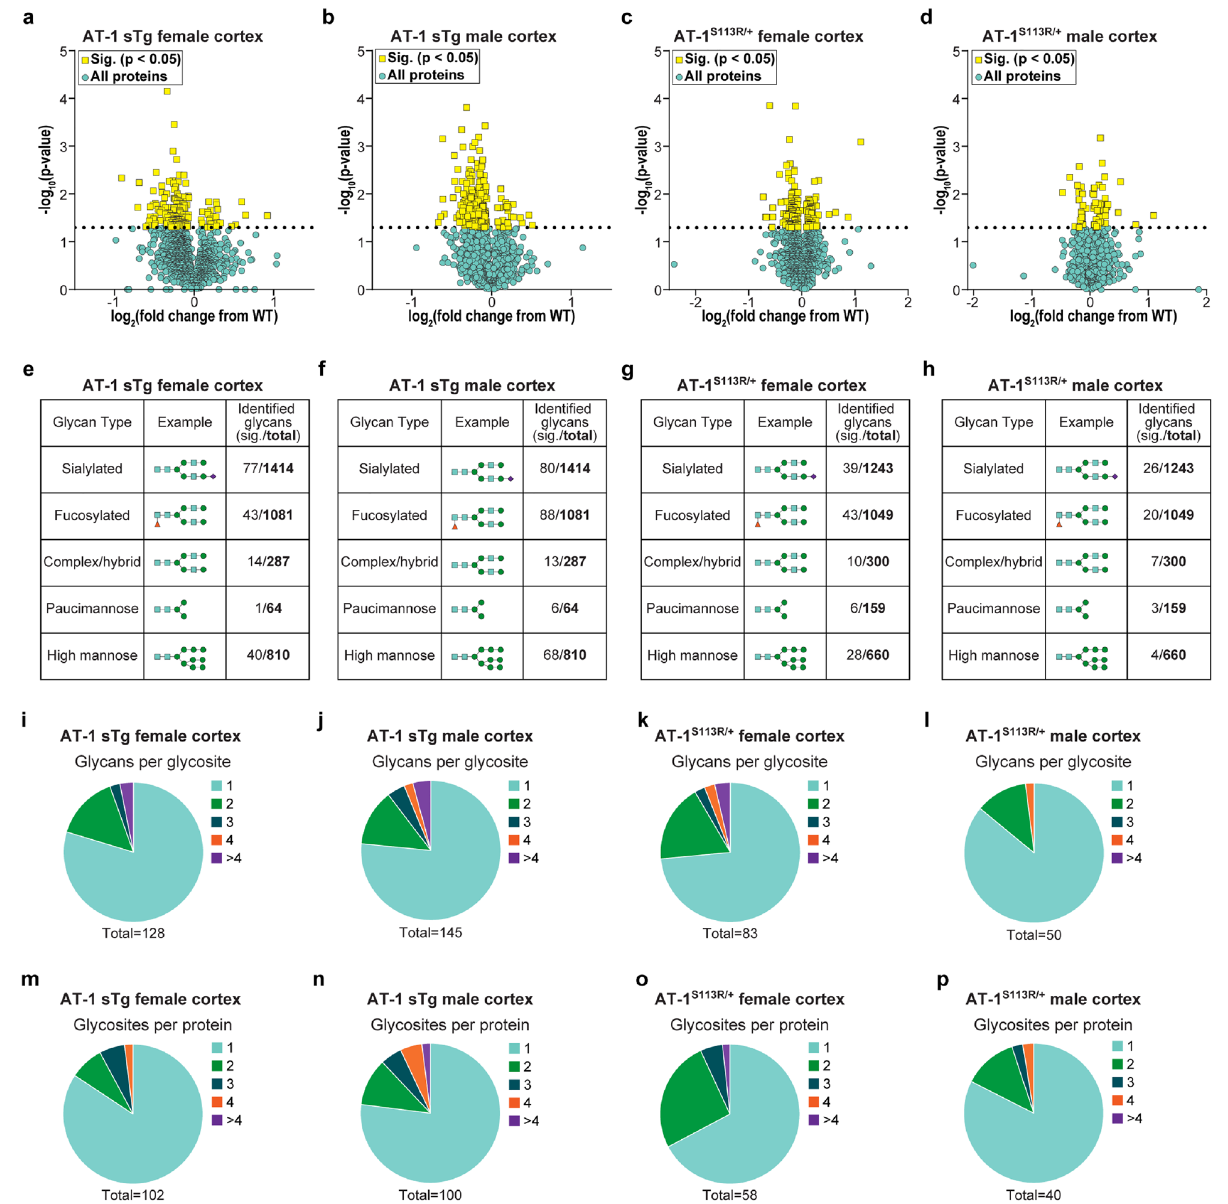
Figure 4. AT-1 sTg and AT-1 S113R/+ display N-glycoproteomic changes across many cortical glycoforms. ( a , b ) Volcano plot displaying all quantified glycoproteins in the cortex of AT-1 sTg ( a ) female (n = 3) and ( b ) male (n = 3), compared with age-matched WT littermates. Statistically significant proteins (175 in female; 255 in male) are highlighted in yellow, and all other proteins are designated in blue. Student’s T-test, P < 0.05. ( c , d ) Volcano plot displaying all quantified glycoproteins in the cortex of AT-1 S113R/+ ( c ) female (n = 3) and ( d ) male (n = 3), compared with age-matched WT littermates. Statistically significant proteins (126 in female; 60 in male) are highlighted in yellow, and all other proteins are designated in blue. Student’s T-test, P < 0.05. ( e – h ) Identified glycans are categorized into five glycan types, and are divided by significant over total identified in cortical ( e ) AT-1 sTg female, ( f ) AT-1 sTg male, ( g ) AT-1 S113R/+ female, and ( h ) AT-1 S113R/+ male. ( i – l) Significant glycans per glycosite are identified in cortical ( i ) AT-1 sTg female, ( j ) AT-1 sTg male, ( k ) AT-1 S113R/+ female, and ( l ) AT-1 S113R/+ male. ( m – p ) Significant glycosites per protein are identified in cortical ( m ) AT-1 sTg female, ( n ) AT-1 sTg male, ( o ) AT-1 S113R/+ female, and ( p ) AT-1 S113R/+